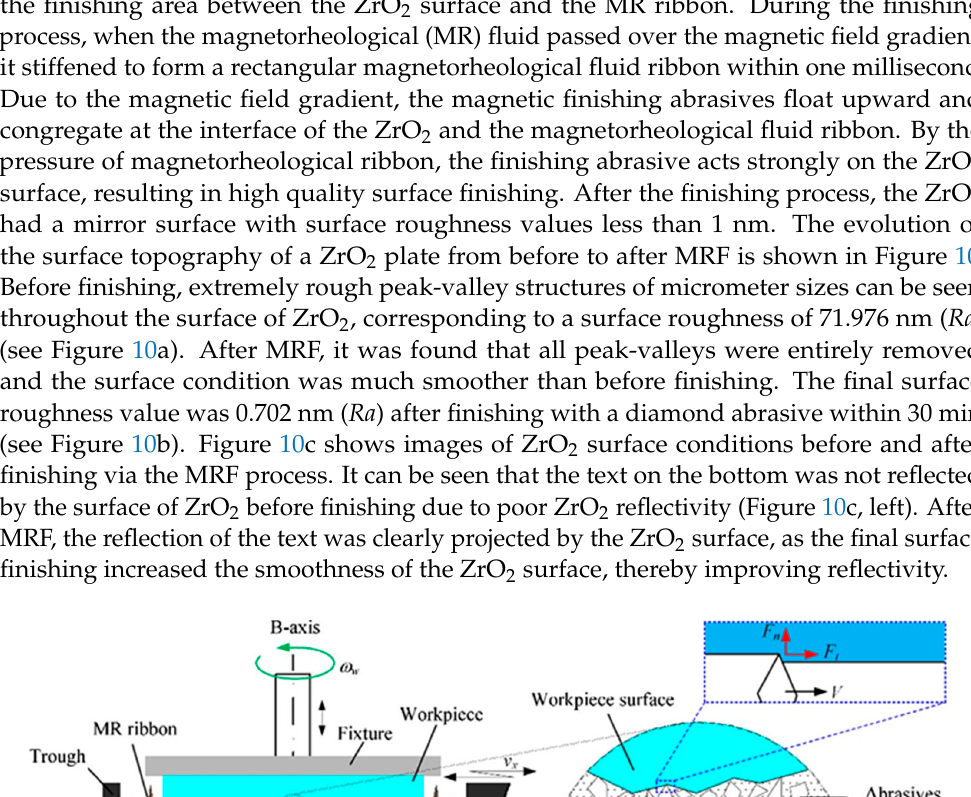
Figure 10. Surface conditions of ceramic plate: ( a ) surface topography of unfinished surface, ( b ) sur- face topography of finished surface, ( c ) images comparison between unfinished surface and finish surface, reused with permission from Elsevier [61]. 2.5. Clustered Magnetorheological Finishing (CMRF) CMRF is a novel finishing process in which dynamic magnetic fields are formed via the synchronous eccentric rotation of numerous magnets [64]. This process has been gen- erally used for obtaining super smooth surface finishes of spherical materials [62,64,106]. Xiao et al. [62] proposed a novel CMRF method for the surface finishing of the silicon nitride (Si 3 N 4 ) ceramic balls. Principle and Function The CMRF process for Si 3 N 4 balls is shown in Figure 11. The CMRF setup is com- posed of upper and lower finishing heads, the Si 3 N 4 balls, and an MRF slurry (mostly a mixture of abrasive particles, Fe powder, and grinding fluid). In the CMRF process, the ceramic balls are placed inside a groove of the lower finishing head, and they are sur- rounded by MRF slurry. The MRF slurry forms a magnetic chain shape because of the